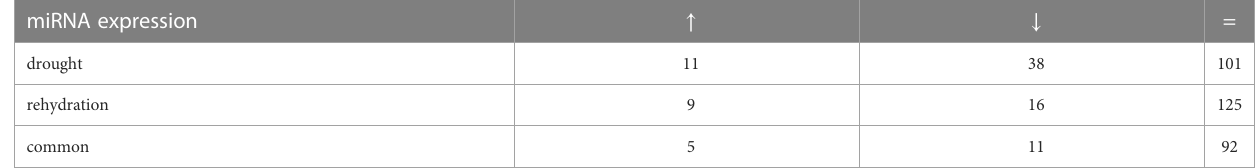
TABLE 1 Summary of changes of conserved microRNA (miRNA) expression in drought- or rehydration-treated barley . miRNA expression